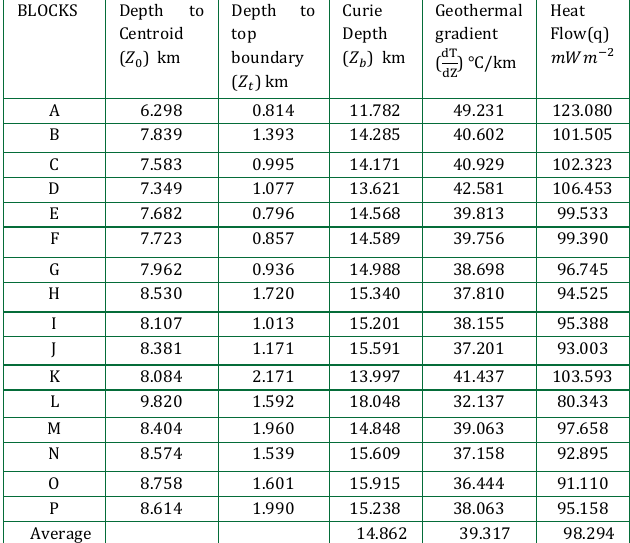
Table 1: Calculated Curie depth, Geothermal gradient and Heat